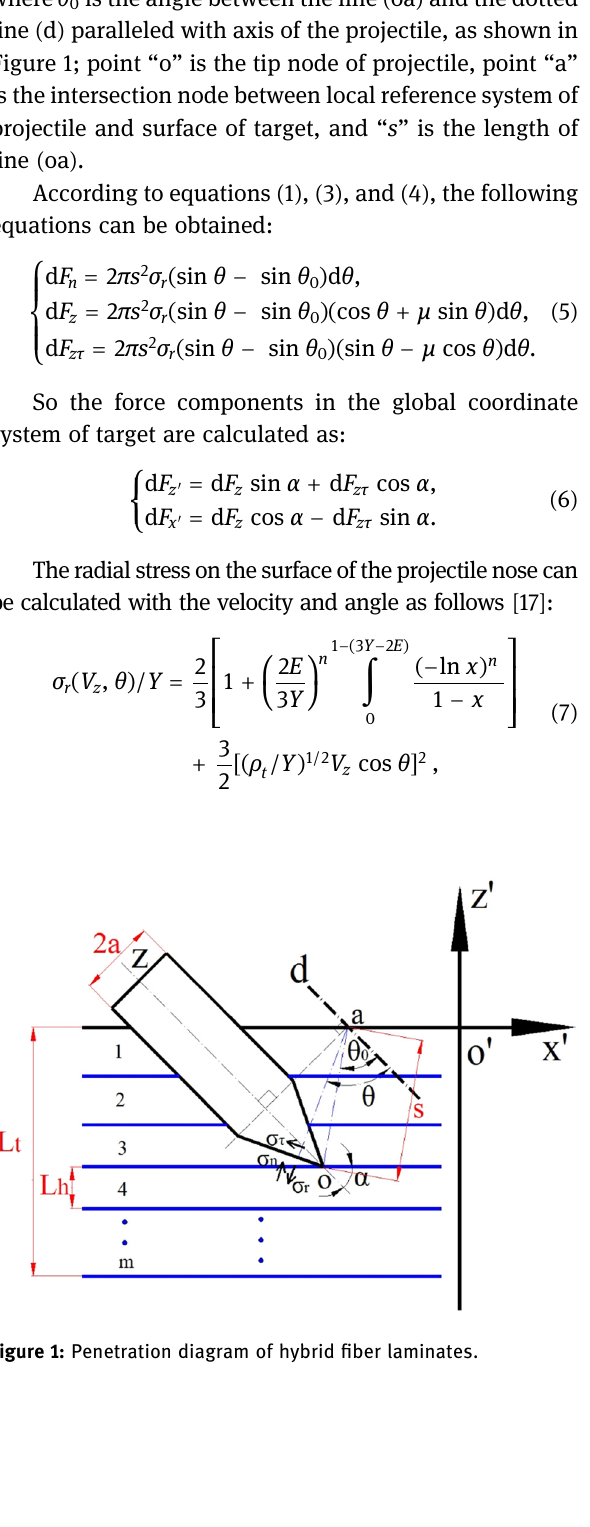
Figure 1; point “ o ” is the tip node of projectile, point “ a ” is the intersection node between local reference system of projectile and surface of target, and “ s ” is the length of line ( oa ) .